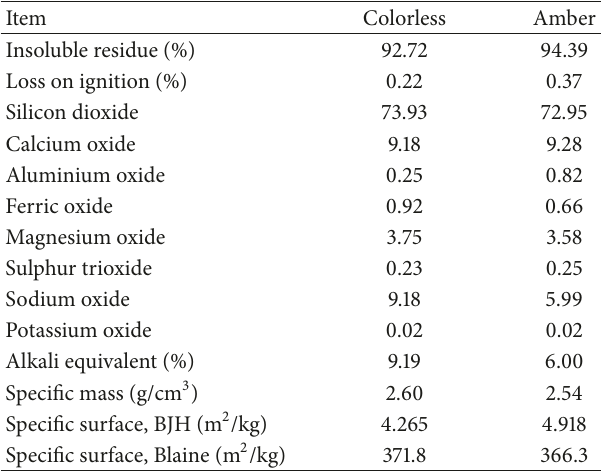
Table 1: Physical and chemical characterization of colorless and amber glass